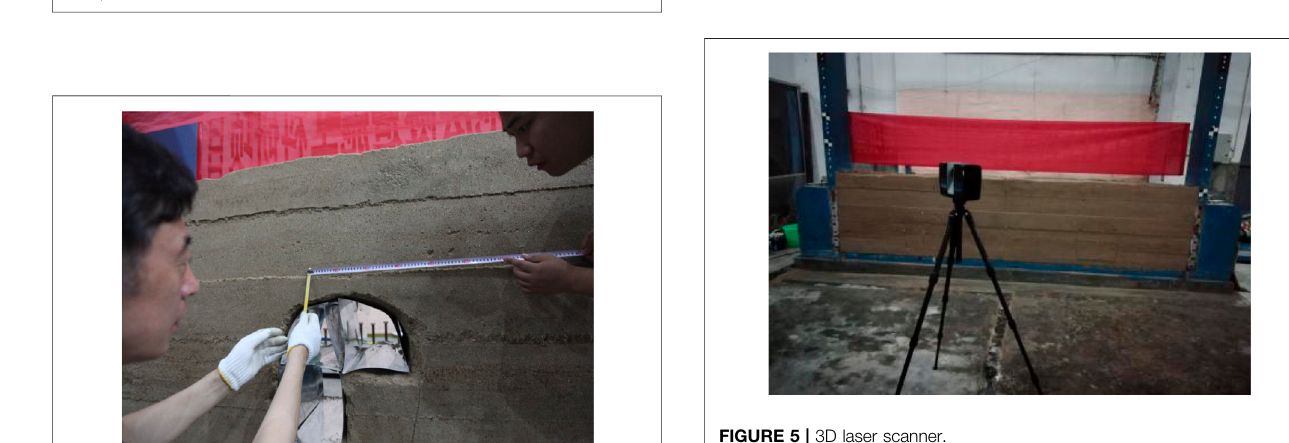
FIGURE 2 | Similar material model and measuring point layout (model front).